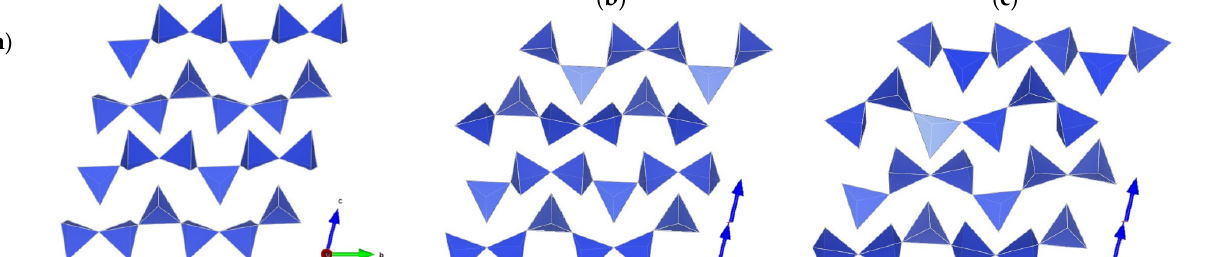
Figure 4. Phase transitions from ( a ) wollastonite-I ( b ) wollastonite-II and ( c ) wollastonite-III. The representations of the structure are realized using the program VESTA [17]; a axis points toward the reader, the green arrow is the b axis, while the blue arrow is the c axis. The blue and the green axis are doubled in ( b ) and ( c ) as it can be observed from the unit-cell parameters of the two polytypes (Table 3).